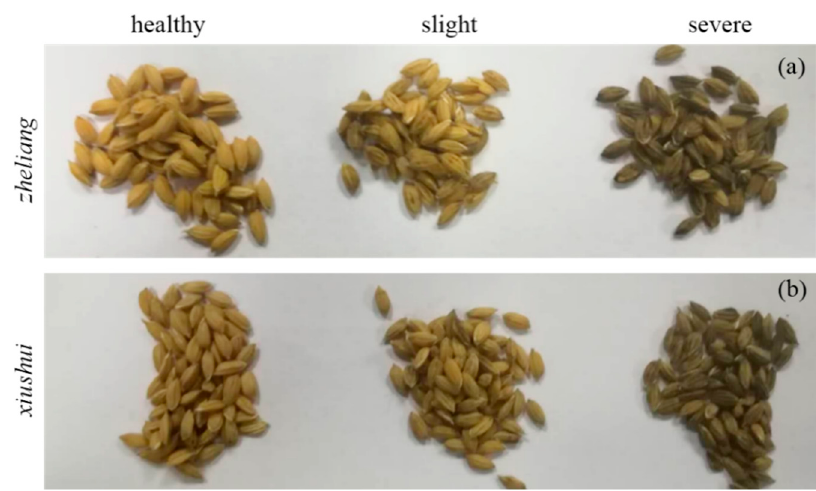
Figure 1. Two genotypes of rice seeds Zheliang ( a ) and Xiushui ( b ) with different infected degrees of rice false smut (RFS).